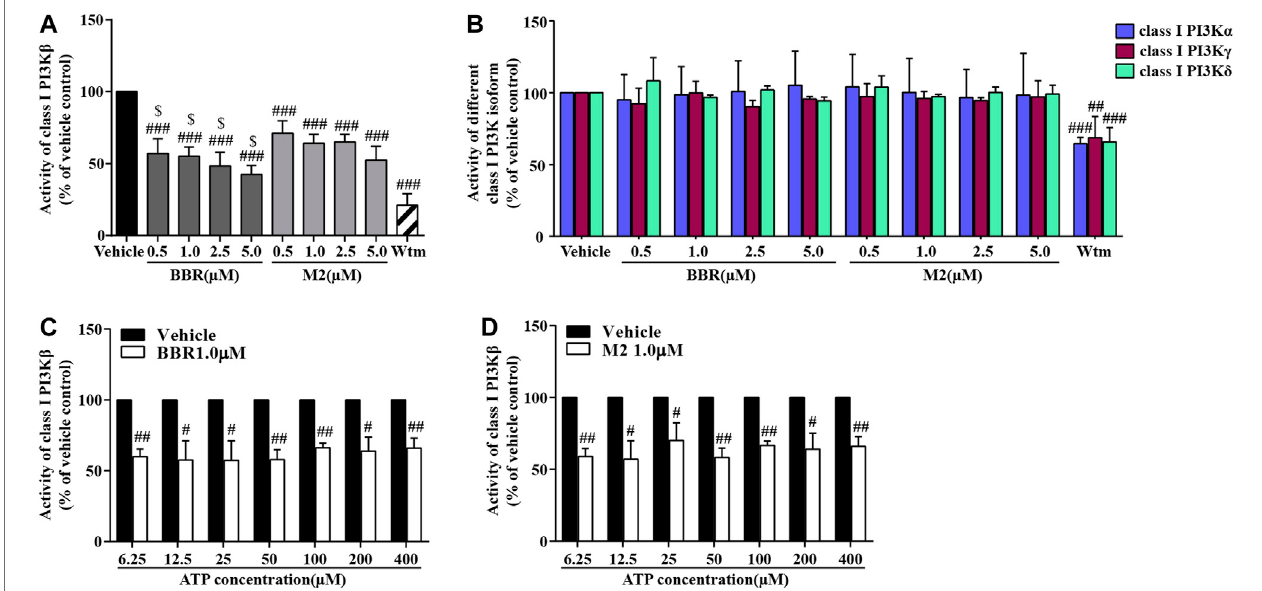
FIGURE 6 | Effects of BBR and M2 on class I PI3K activities. (A) After treatment with the vehicle control (0.1% DMSO), BBR, M2, or Wtm (100 nM) for 20 min, the activitiesofclassIPI3K β weredetermined. (B) Aftertreatment,theactivitiesofclassIPI3K α , γ ,and δ weredetermined. (C) AftervehicleorBBRtreatment,aclassIPI3K β activity assay was performed with different concentrations of ATP for 1 h. (D) After the vehicle control or M2 treatment, the class I PI3K β activity assay was performed withdifferentconcentrationsofATPfor1 h.Dataareexpressedasmean ± SDofthree – fi veindependentexperiments.Statisticallysigni fi cantdifferencescompared with the vehicle control group are indicated by # p < 0.05, ## p < 0.01, and ### p < 0.001, and statistically signi fi cant differences between the BBR and M2 groups at the same concentration are indicated by $ p < 0.05, $$ p < 0.01.